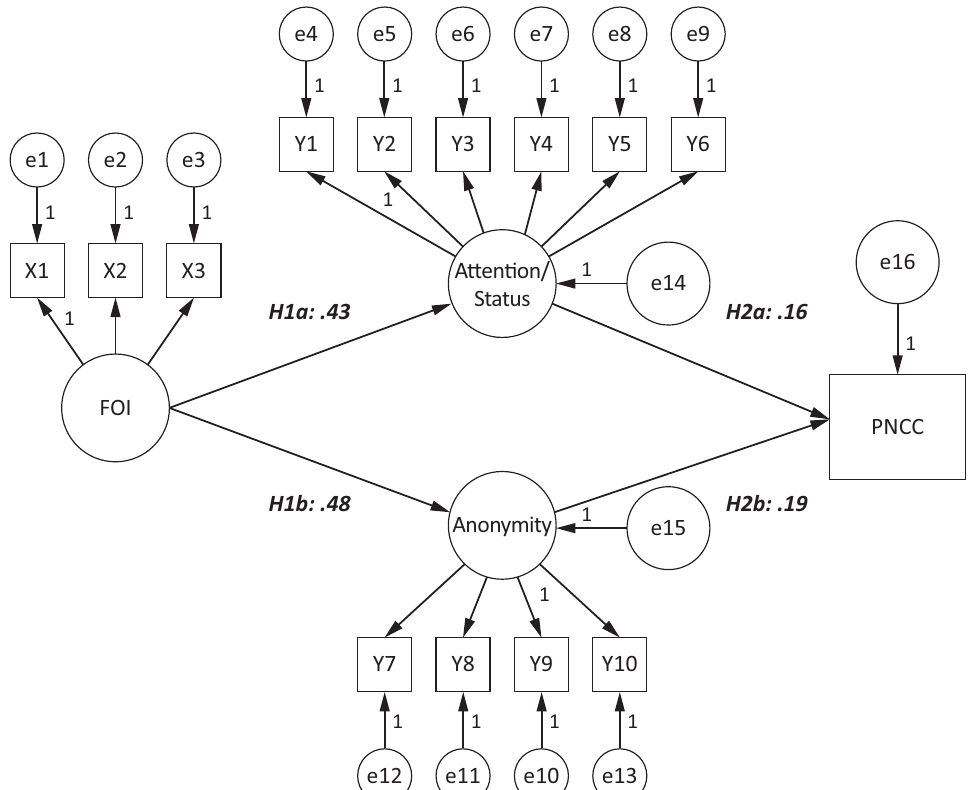
Figure 1. Results of testing hypotheses with standardized path